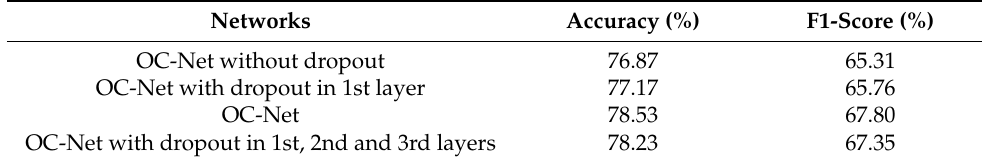
Table 7. Performance comparison of OC-Net variants.